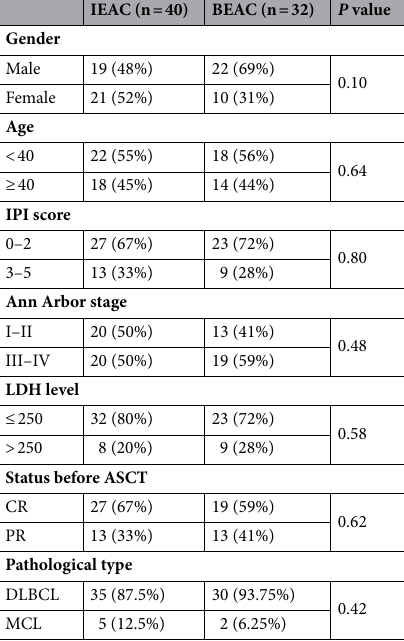
Table 1. Patients’ baseline demographics and clinical characteristics. IPI international prognostic index, LDH lactate dehydrogenase, CR complete remission, PR partial remission, ASCT autologous stem cell